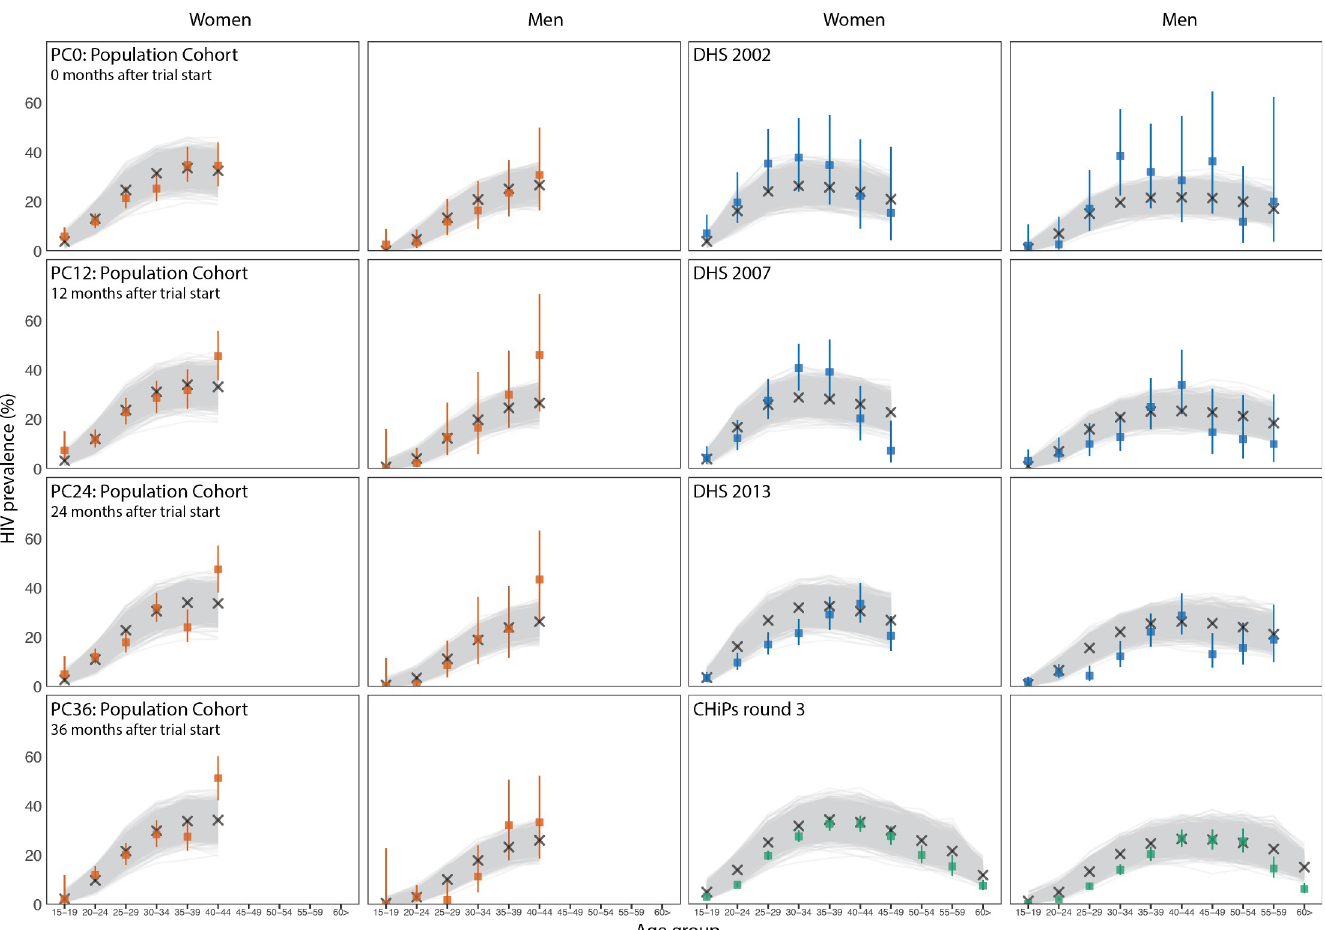
Fig 4. Calibration of PopART-IBM to PC, DHS and CHiPs datasets for women (columns 1 and 3) and men (columns 2 and 4). For all graphs, the x-axis shows 5 year age groups, starting at 15–19 years. Panel shows calibration to HIV prevalence in PC0-PC36 (columns 1–2); HIV prevalence from 2002, 2007 and 2013 Zambia DHS surveys (top 3 rows, columns 3–4); HIV prevalence from CHiPs round 3 (bottom row, columns 3–4). In each graph the coloured bars represent the data used for calibration (observed proportions in each subgroup, with 95% confidence intervals), with corresponding colour in the Gantt chart in Fig 5; the grey lines represent the outputs from the 1,000 calibrated model runs; and the crosses represent the best model fit